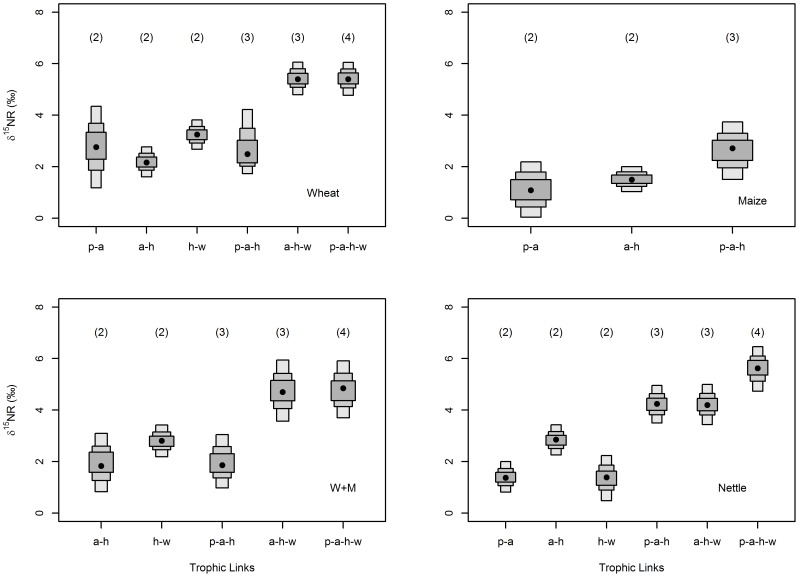
Probability distributions of mean nitrogen range (NR) for different food chain lengths for each food chain.NR is difference between mean δ15N (‰) of community end members, based on resampling (n = 10,000) of uncertainty in sample mean estimates. Black dots represent mode (of means), while shaded boxes (dark to light) show 50%, 75% and 95% credible intervals for mean estimates. No wasps were obtained for the maize food chain. x-axis labels are species identity: p = plant, a = aphid, h = hoverfly, w = wasp. Parenthesis number shows food chain length.